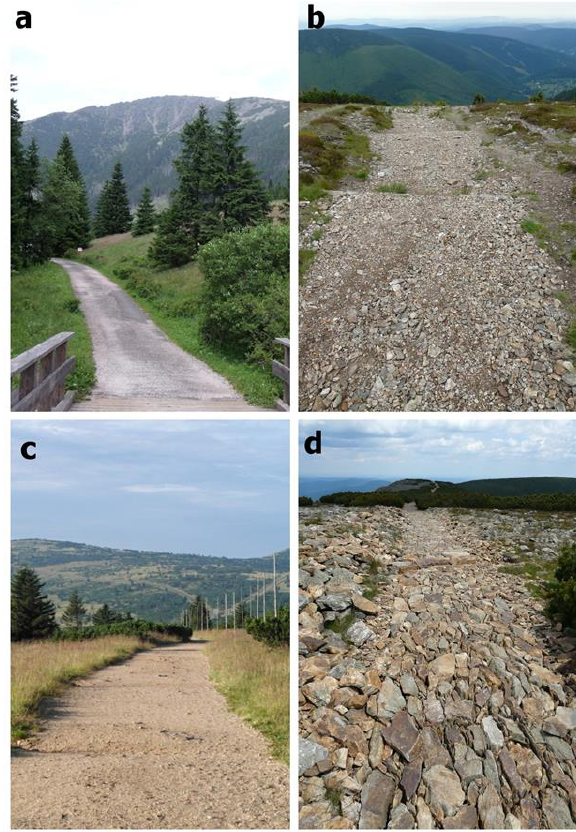
Fig. 5. Surface types determined in the study area: asphalt (a), gravel (b), sand (c), and stones (d)